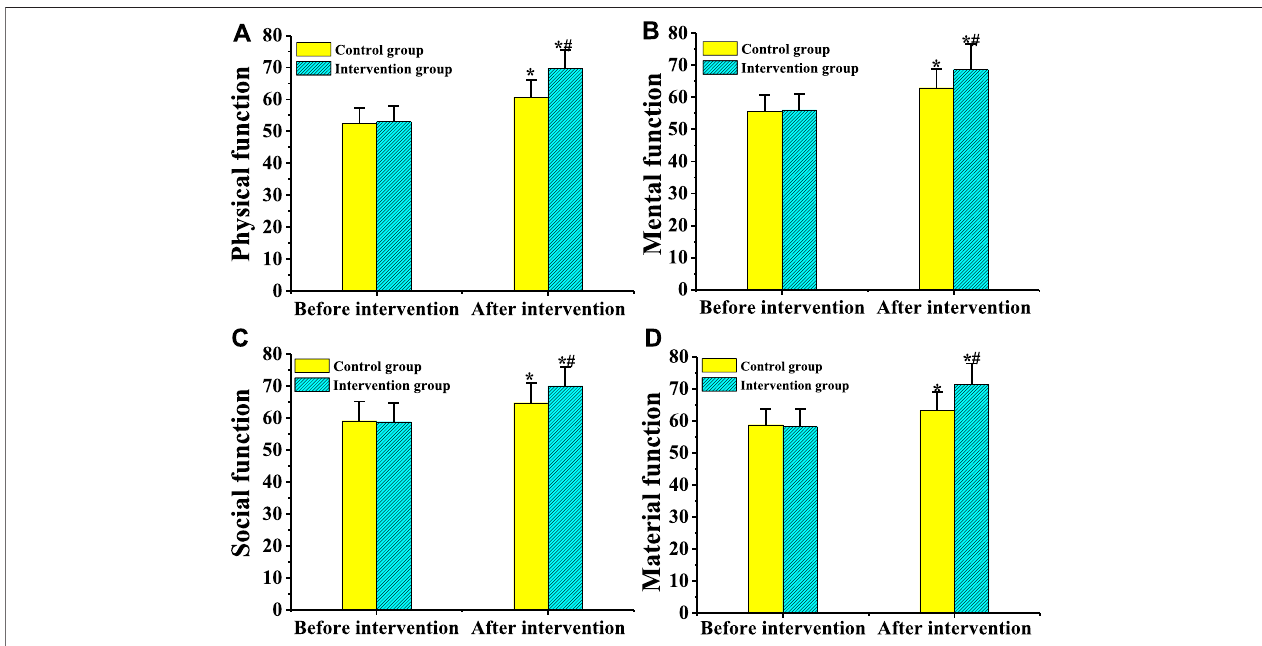
FIGURE 14 | Comparison on the quality of life of patients from the two groups before and after psychological intervention.[Note: (A) : Comparison of the physical functionofthetwogroupsofpatientsbeforeandafterpsychologicalintervention; (B) :Comparisonofthepsychologicalfunctionofthetwogroupsofpatientsbeforeand after psychological intervention; (C) : Comparison of the social function of the two groups of patients before and after psychological intervention; (D) : Comparison of the substance function ofthetwogroups ofpatientsbefore and after psychologicalintervention; * indicated p < 0.05 compared withbeforethe intervention; #showed that p < 0.05 in contrast to the control group].